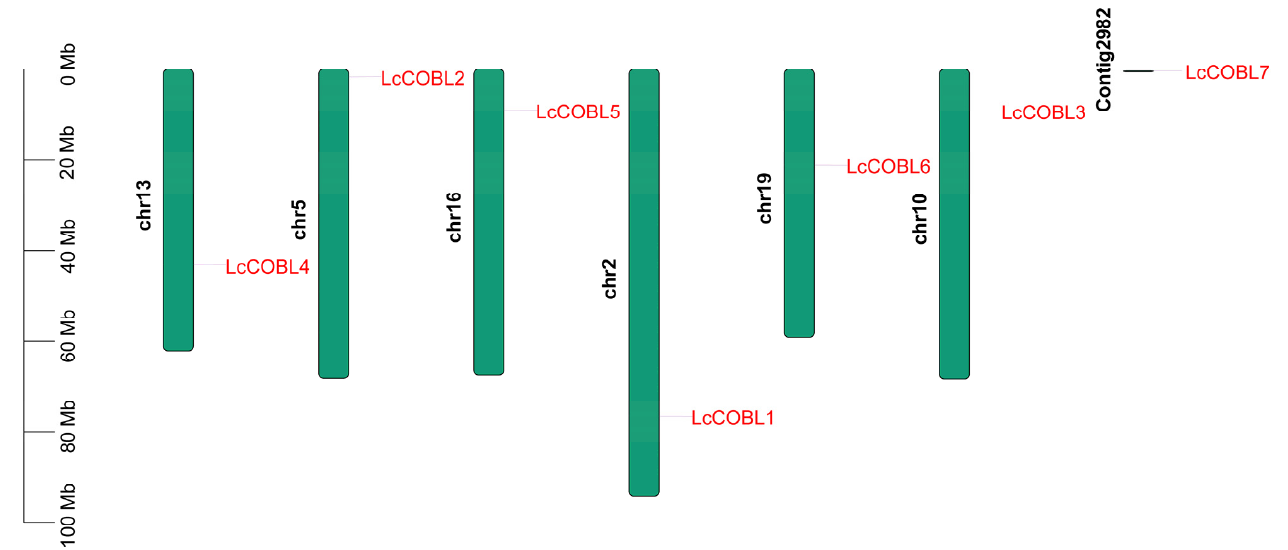
Figure 3. Chromosomal location analysis of LcCOBLs . The size of a chromosome is expressed by its relative length. Scale bar on the left indicates the chromosome lengths (Mb).